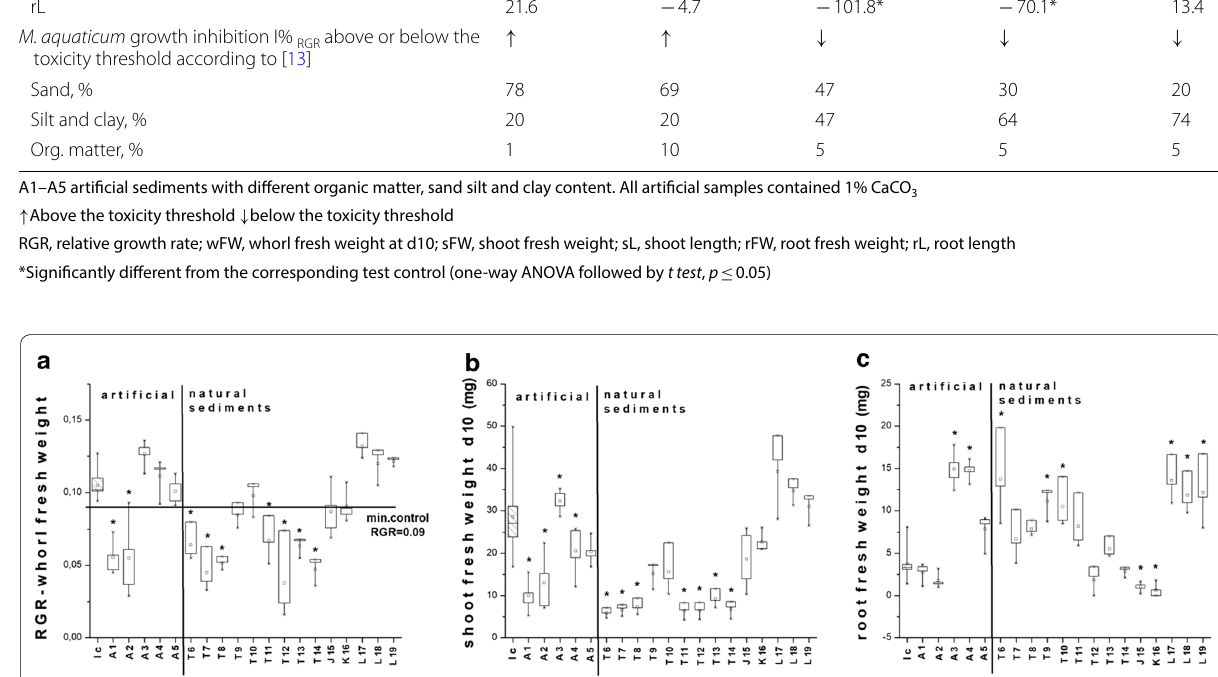
Fig. 1 Myriophyllum aquaticum growth in tested sediments compared to the long-term laboratory control. a Relative growth rate based on whorl fresh weight, b shoot fresh weight, c root fresh weight (Samples A1–5: artificial sediments with various organic matter, sand and fine particle content. Natural samples: T6–14 river Tamiš; J15 river Jegrička; K16 river Krivaja; L17–19 lake Ludaš. RGR, relative growth rate based on whorl fresh weight. [*Significantly different from the long-term control (one-way ANOVA followed by t test ,